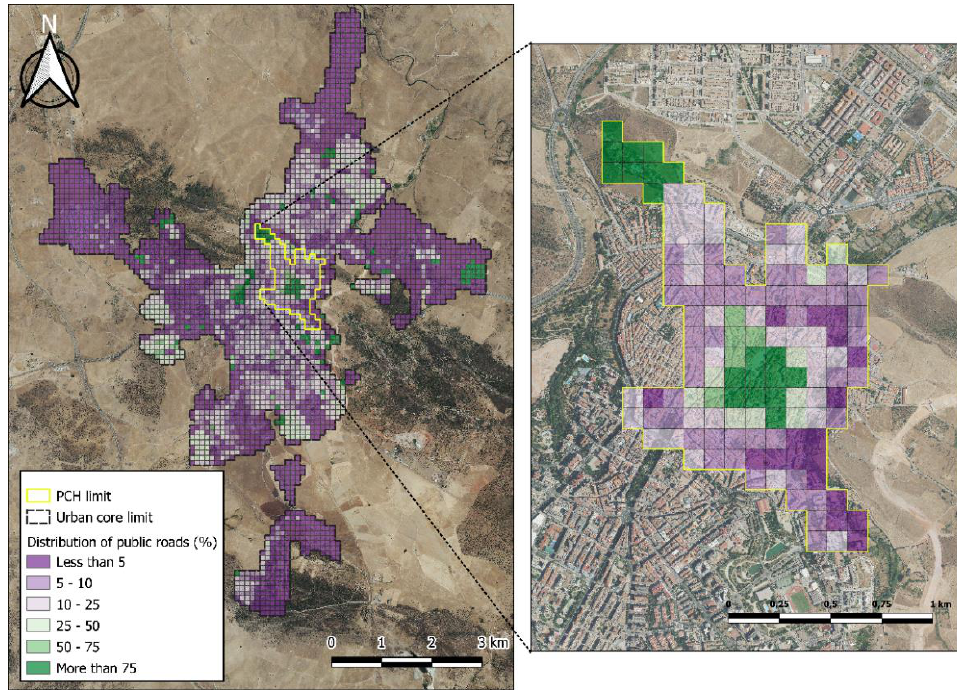
Figure 12. Public road distribution comparison.